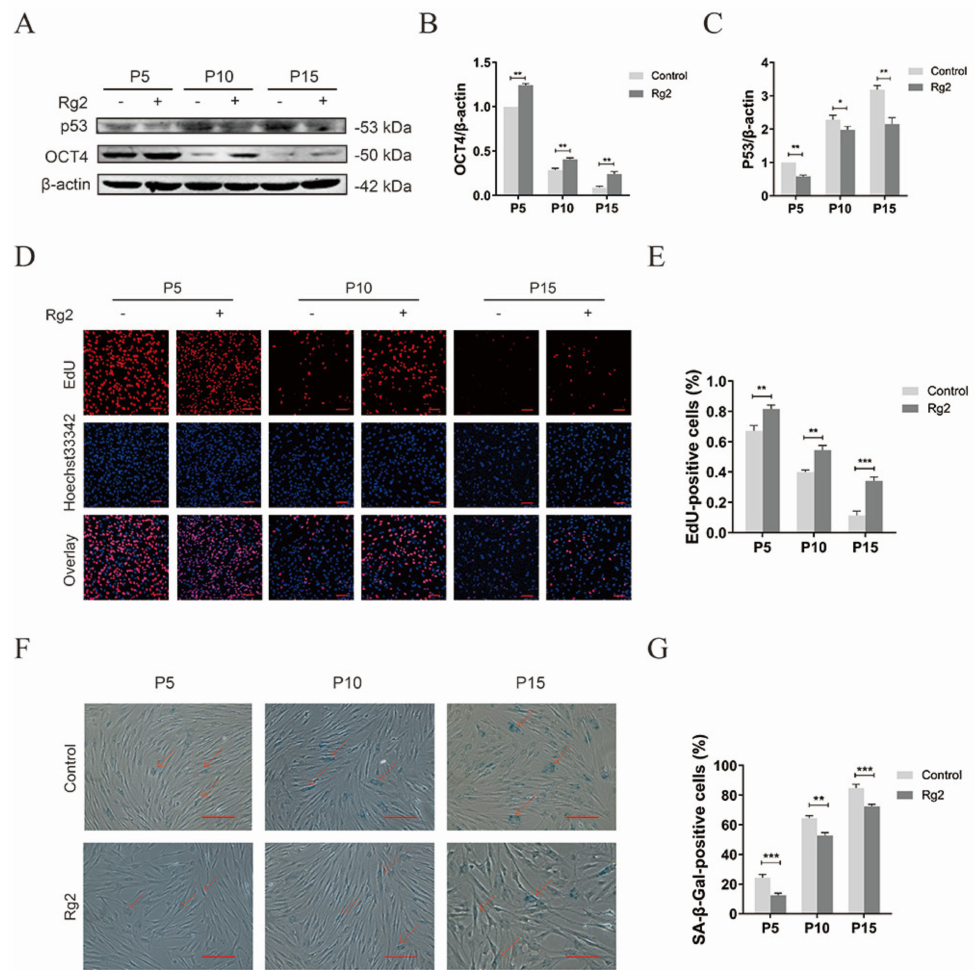
Figure 8. Ginsenoside Rg2 improved the longevity of pMSCs during long–term culture. ( A ) Western blot analysis with anti– OCT4 and anti–P53 antibodies in pMSCs with/without Rg2 treatment at P5, P10, and P15. ( B ) Quantification of the OCT4 expression levels in ( A ). ( C ) Quantification of the P53 expression levels in ( A ). ( D ) EdU staining of pMSCs with/without Rg2 treatment at P5, P10, and P15. Scale bar = 200 µ m. ( E ) Quantification of the EdU staining in ( D ). ( F ) SA– β –gal staining of pMSCs with/without Rg2 treatment at P5, P10, and P15. SA– β –gal–positive cells were indicated by red arrows. Scale bar = 10 µ m. ( G ) Quantification of the SA– β –gal staining in ( F ). * p < 0.05, ** p < 0.01, and *** p < 0.001; n =